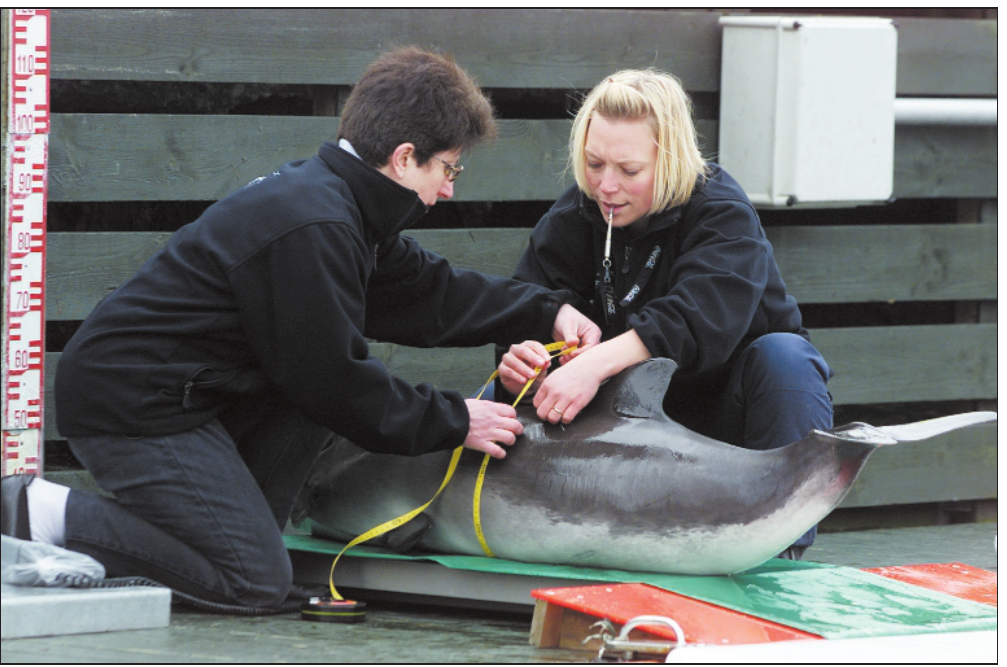
Fig. 2 . Taking girth measurements of a captive har- bour porpoise, Fjord&Bælt, Kerteminde, Denmark. (Photo: